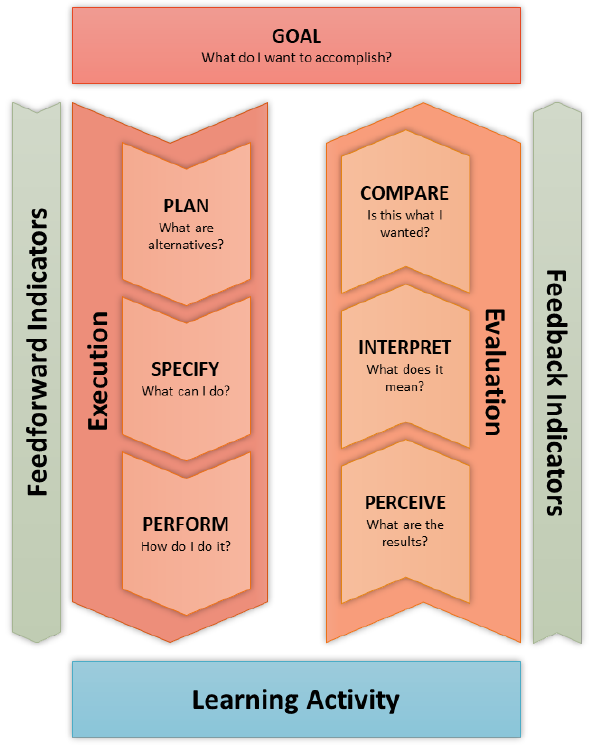
Figure 3. The seven stages of the personalized learning activity